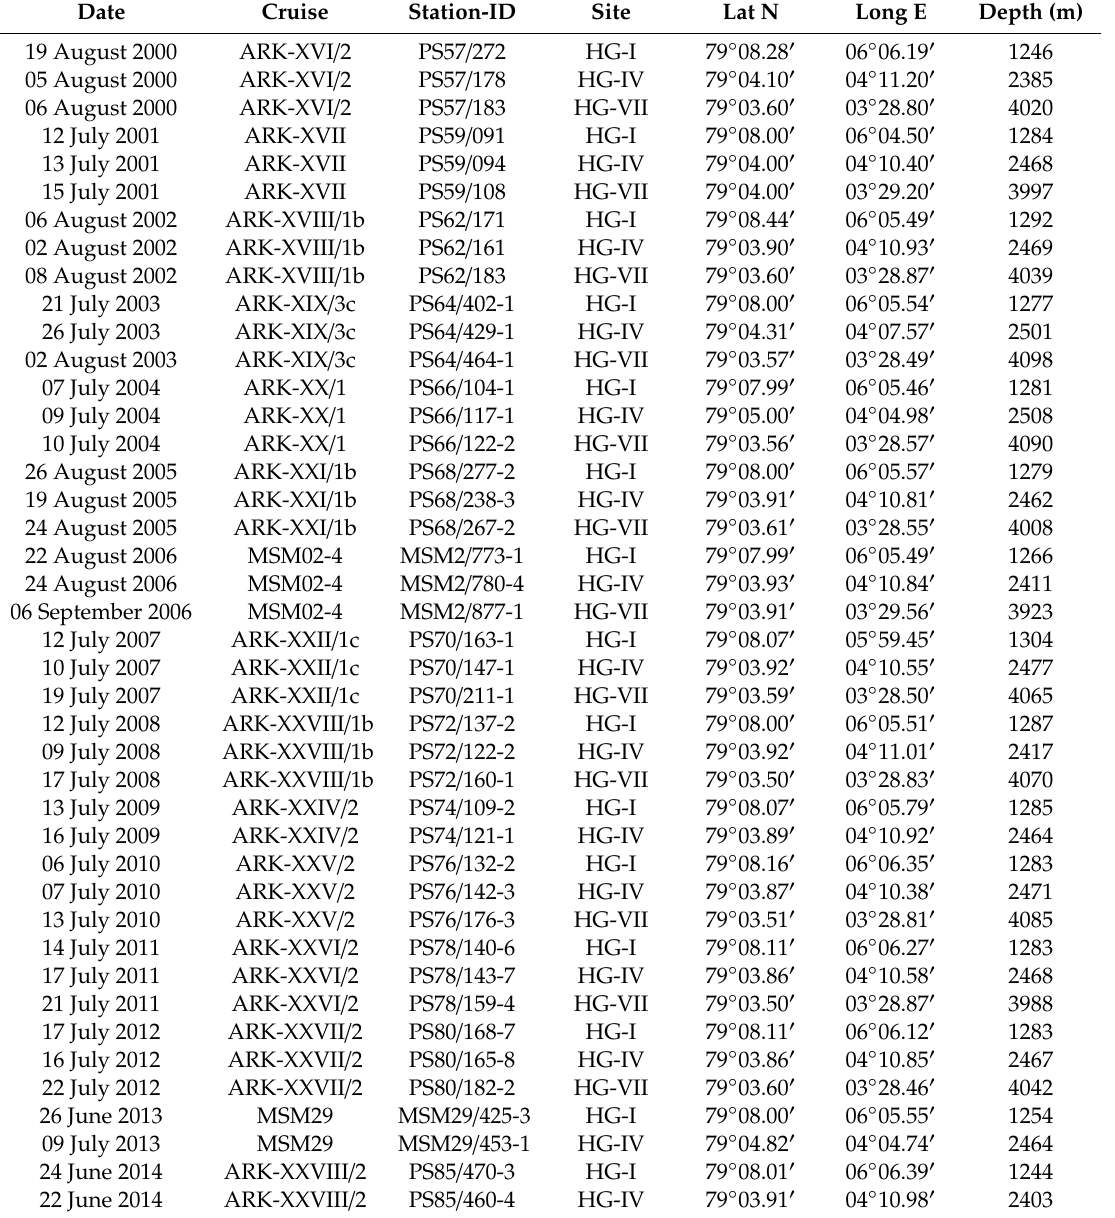
Table 1. Sampling dates, locations, and sampling